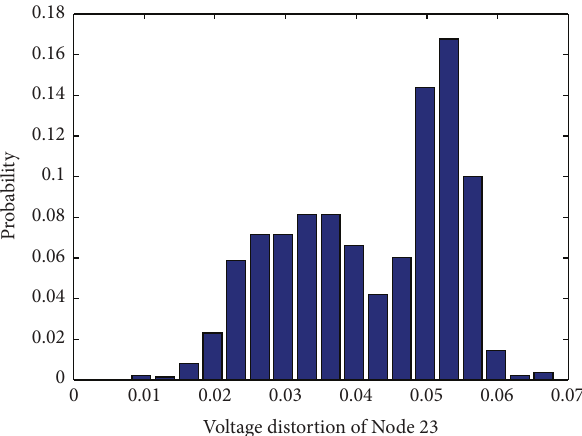
Figure 13: The probability distribution of voltage distortion in node 23.